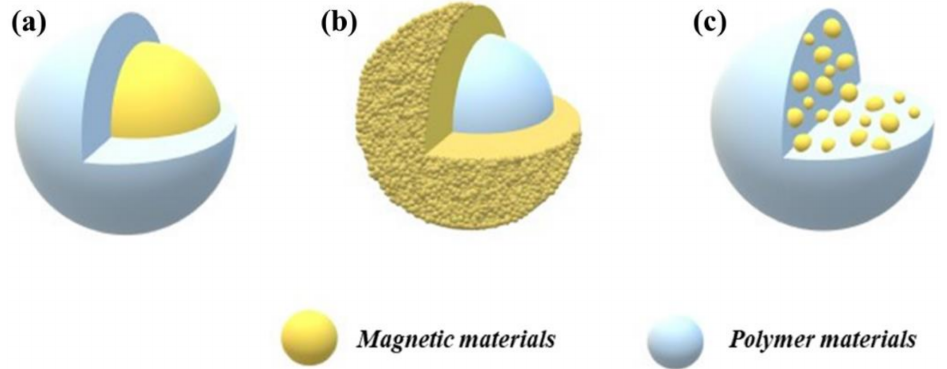
Figure 1. Various morphologies of magnetic polymer nanoparticles: ( a ) Magnetic core-polymer shell, ( b ) polymer core-magnetic shell, and ( c ) magnetic particles embedded in a polymeric